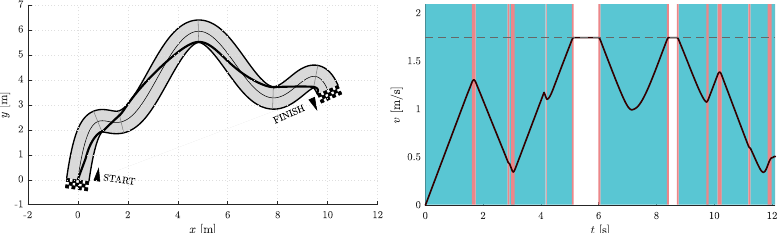
Figure 6. Resulting path as optimization result for N free = 2 and N seg = 1 ( left ) with the correspond- ing velocity profile ( right ). Blue vertical bands indicate intervals where the acceleration reaches its maximum allowable values. Similarly, red vertical bands indicate intervals where the jerk reaches its maximum allowable value.